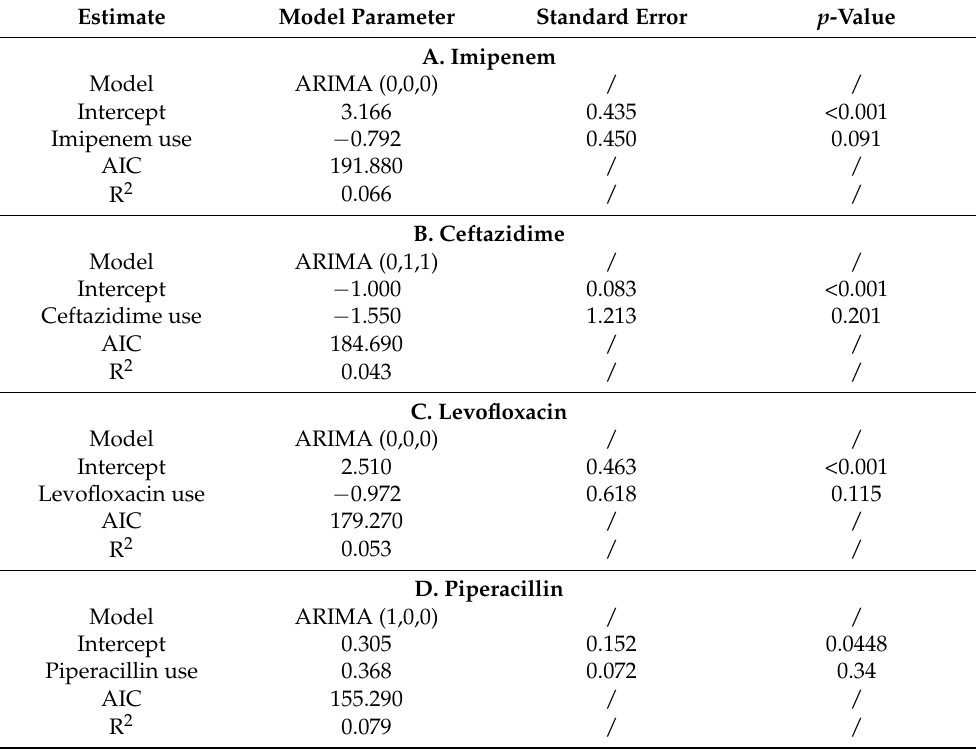
Table 6. Dynamic regression models for the resistance of P. aeruginosa to the additional antimicrobials explored in this study, taking into account their hospital use. The transfer models refer to